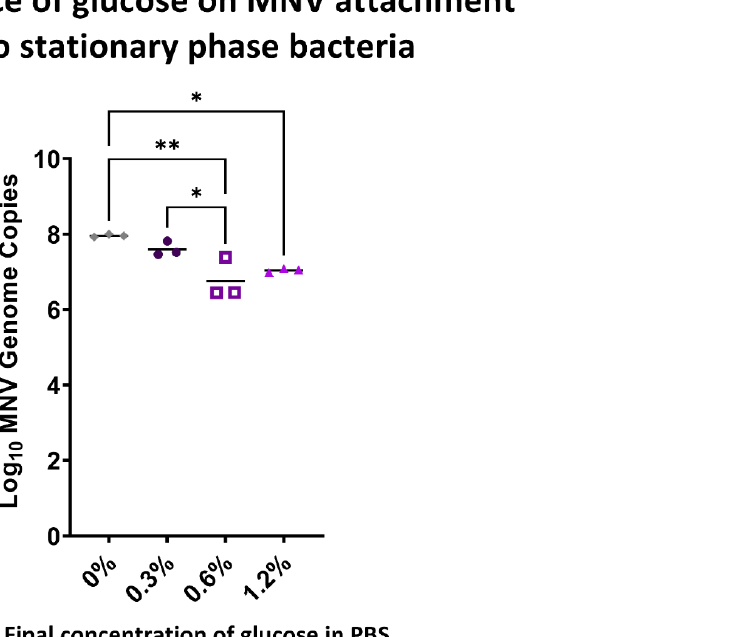
Figure 4. Impact of varying glucose concentrations on MNV attachment to E. cloacae. MNV genome copies were measured using RT-qPCR after 1 h of viral attachment to E. cloacae in PBS only (0% glucose) or PBS-G mediums with 0.3%, 0.6%, or 1.2% glucose. The attachment was assessed using E. cloacae in the stationary phase. * designates an adjusted p -value of ≤ 0.05, ** designates an adjusted p -value of ≤0.005; n = 3.